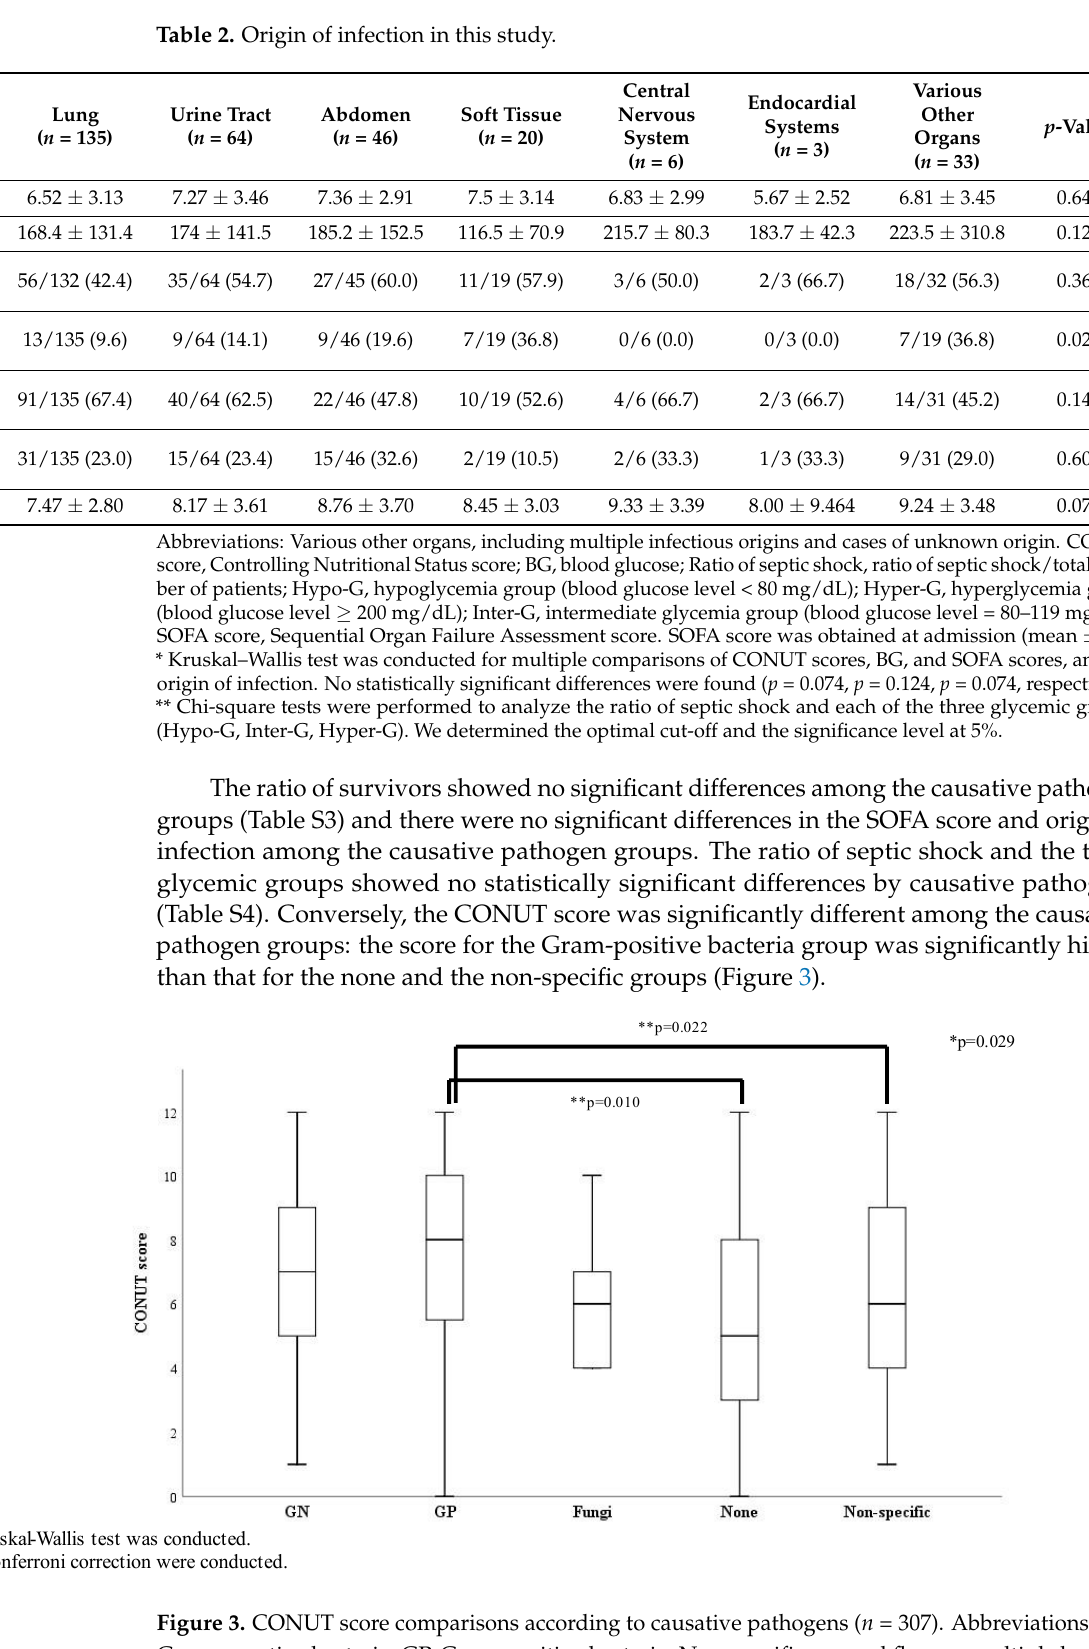
Figure 3. CONUT score comparisons according to causative pathogens ( n = 307). Abbreviations: GN, Gram-negative bacteria; GP, Gram-positive bacteria; Non-specific, normal flora or multiple bacteria were detected but causative pathogenic bacteria could not be identified.